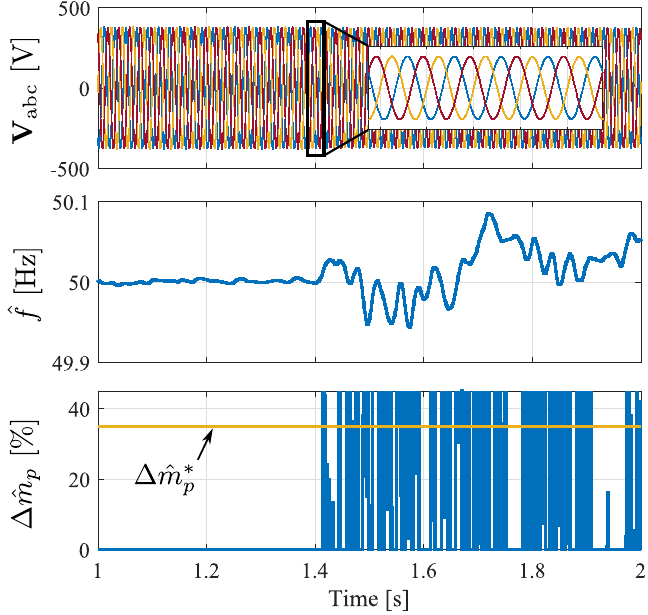
Figure 6. Case 1: Island detection test to evaluate detection